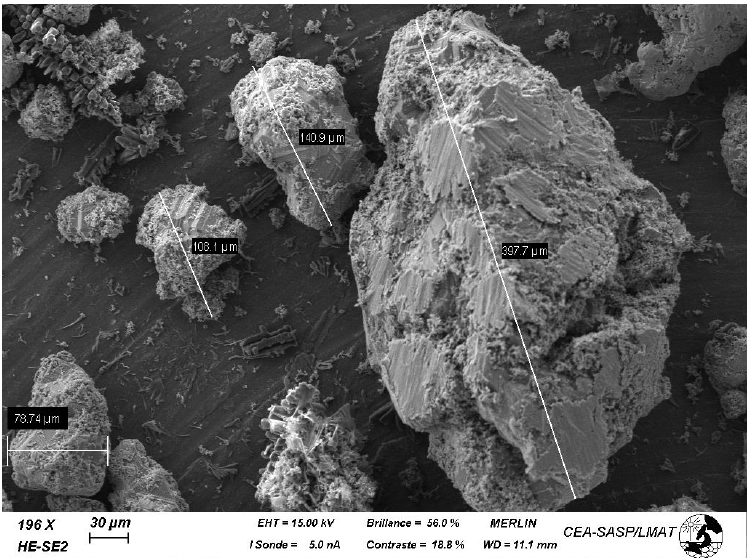
Figure 5. SEM micro-morphology of titanium metal deposit on the cathode under the current deposit of 60 mA · cm − 2 in LiCl-LiF-TiF 3 (0.62 mol/kg) at 853 K (580 ◦